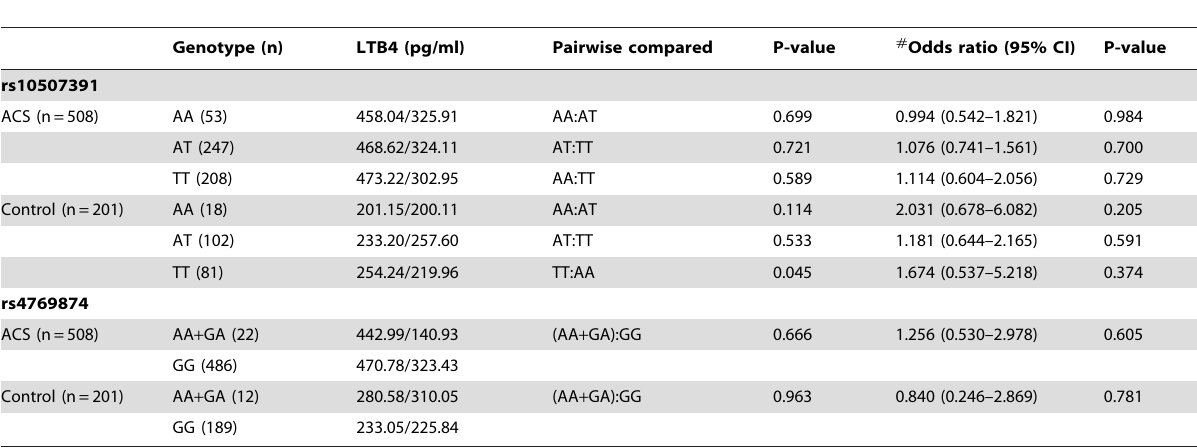
Table 5. Serum LTB4 levels and ALOX5AP polymorphisms in ACS and control